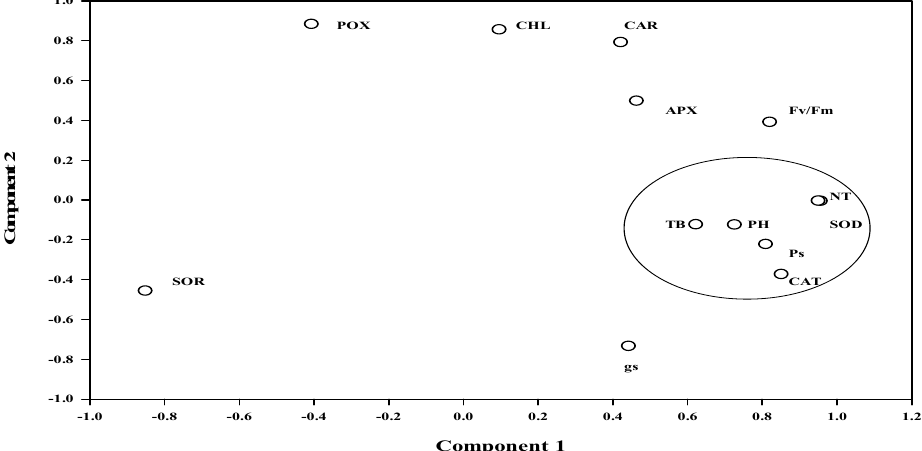
Figure 4. Principal component analysis results showing an association of the parameters on component axes. Here, PH, NT, TB, Ps, g s , Fv/Fm, CHL, CAR, SOD, POX, CAT and APX are the plant height, number of tillers, total biomass, photosynthetic rate, stomatal conductance, photosynthetic efficiency, chlorophyll, carotenoids, superoxide dismutase, peroxidase, catalase and ascorbate peroxidase, respectively.